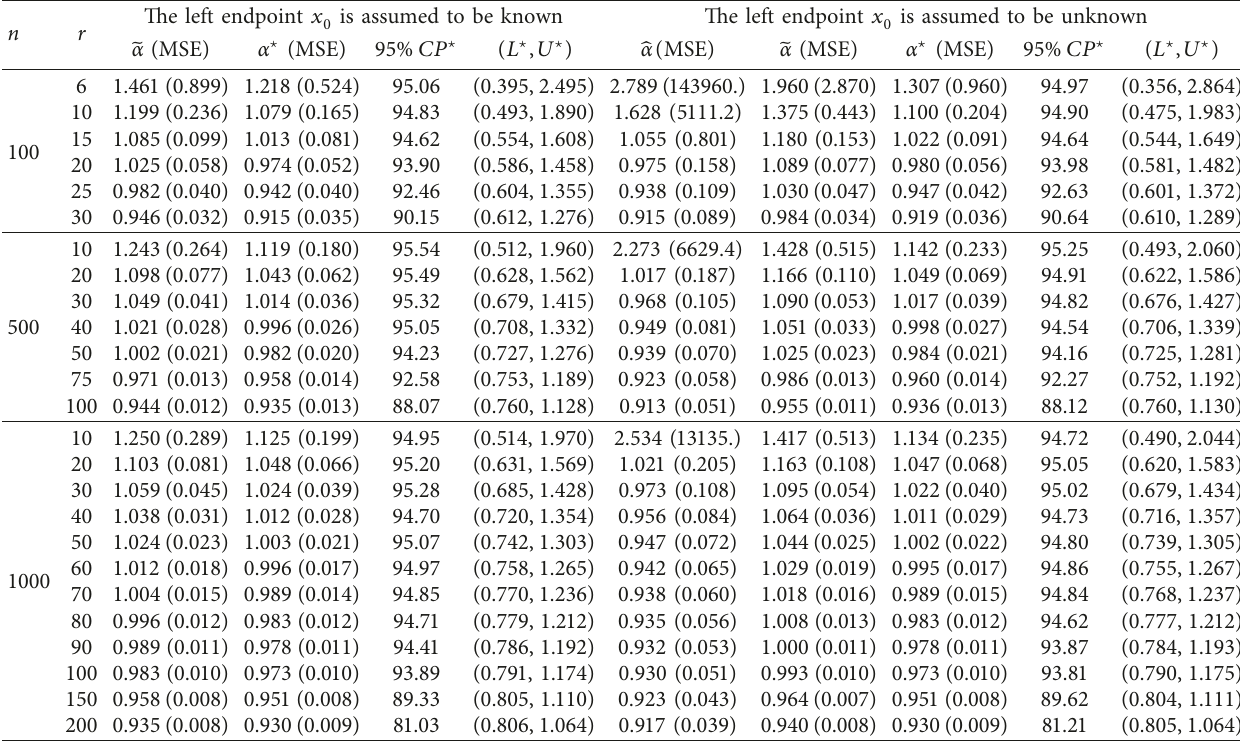
, ... , X r : n for different values 1 : n ) . 1